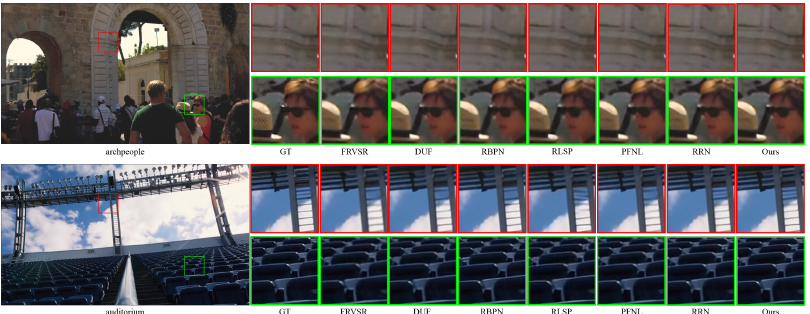
Figure 9. Comparison of reconstruction results with different methods in the Udm10